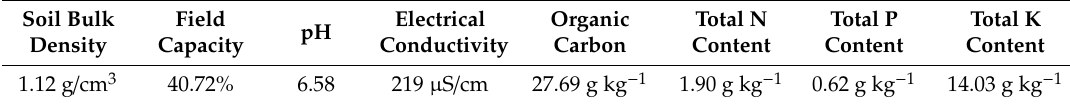
Table 2. Soil physicochemical